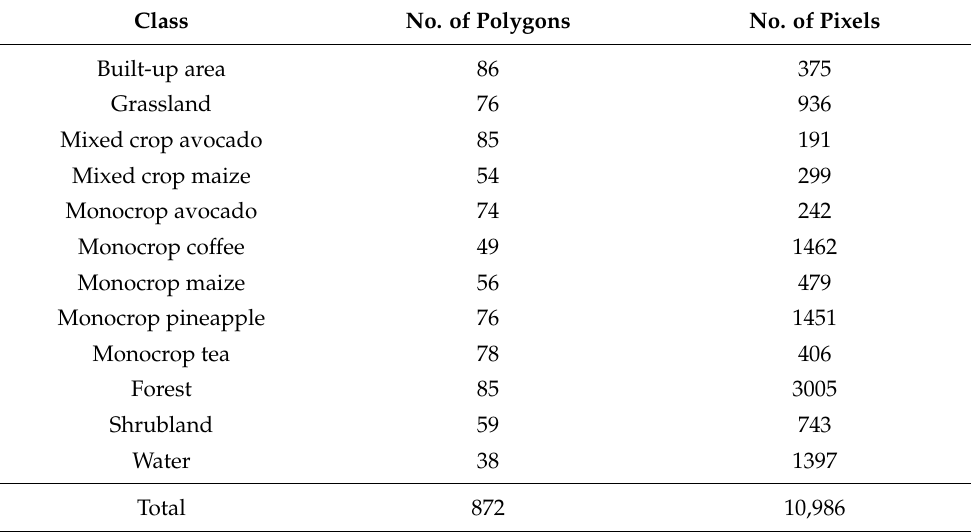
Table 6. The number of polygons (i.e., field reference points) and pixels used per